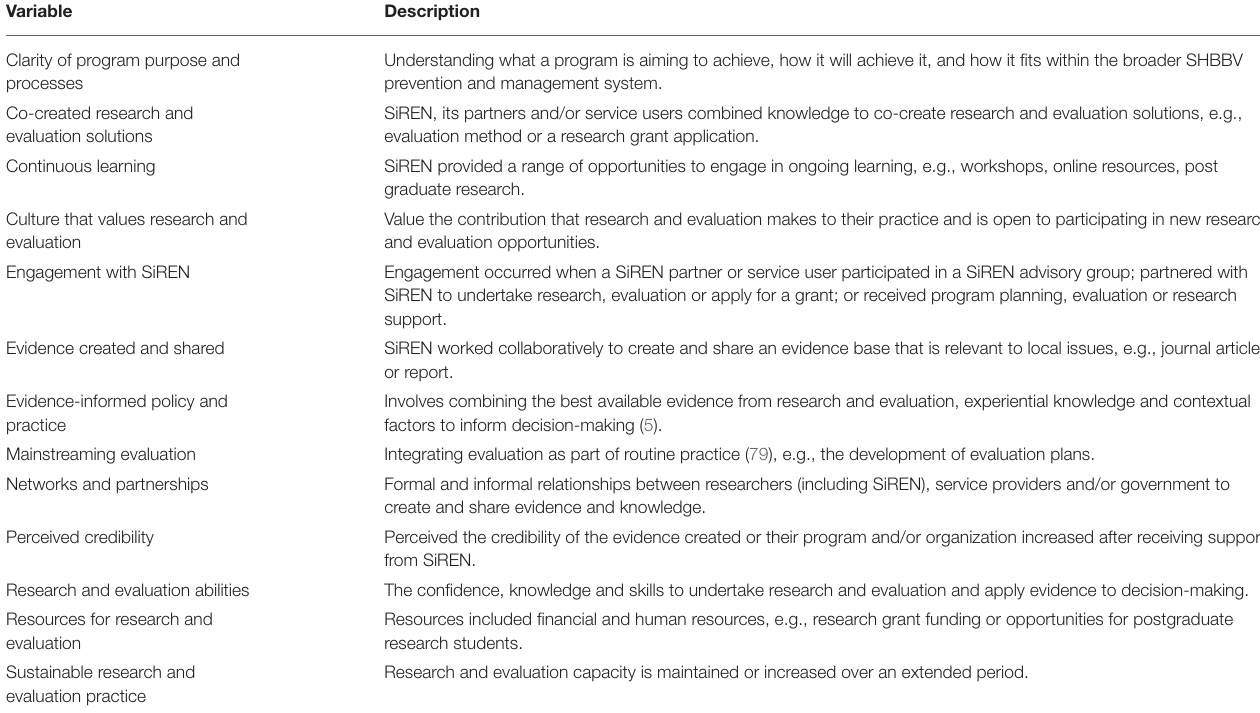
TABLE 3 | A description of impact and outcome variables.